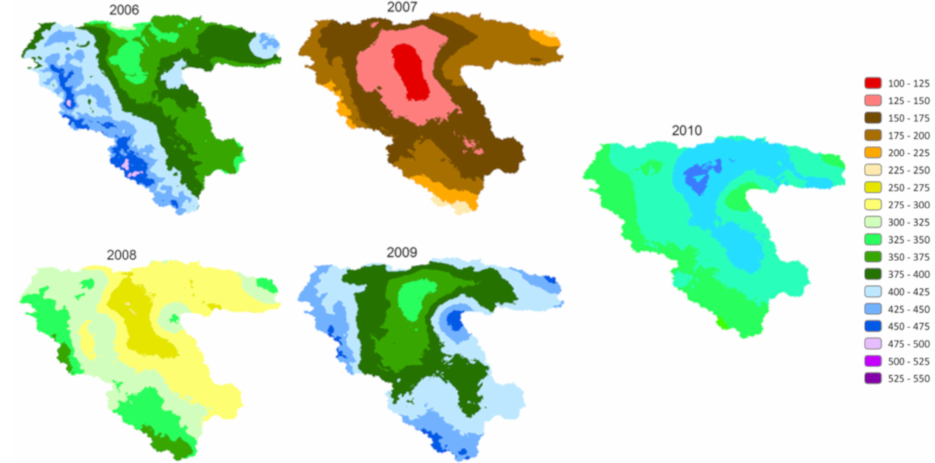
Figure 4. Precipitation (mm) in Lake Urmia basin in five investigated water years (September–August) from 2006–2007 to 2010–2011, based on cokriging interpolation of in-situ records, the Tropical Rainfall Measuring Mission (TRMM), and Digitized Elevation Model